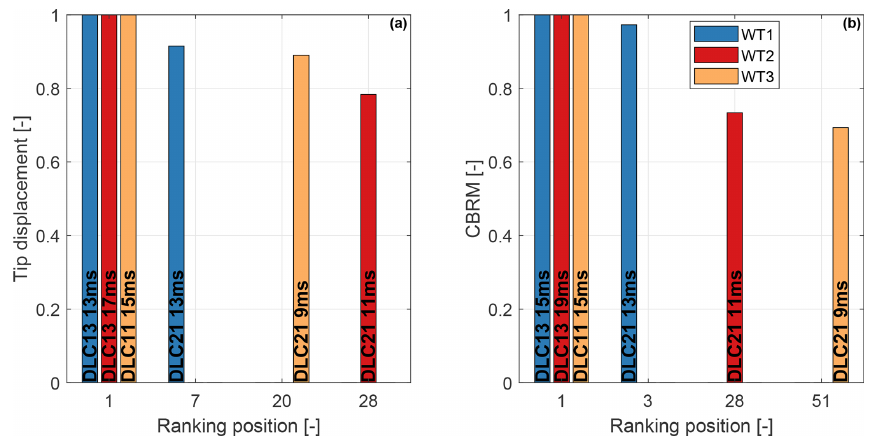
Figure 5. Ranking of normalized blade tip displacement (a) and combined blade root moment (CBRM) (b) for the three turbines.